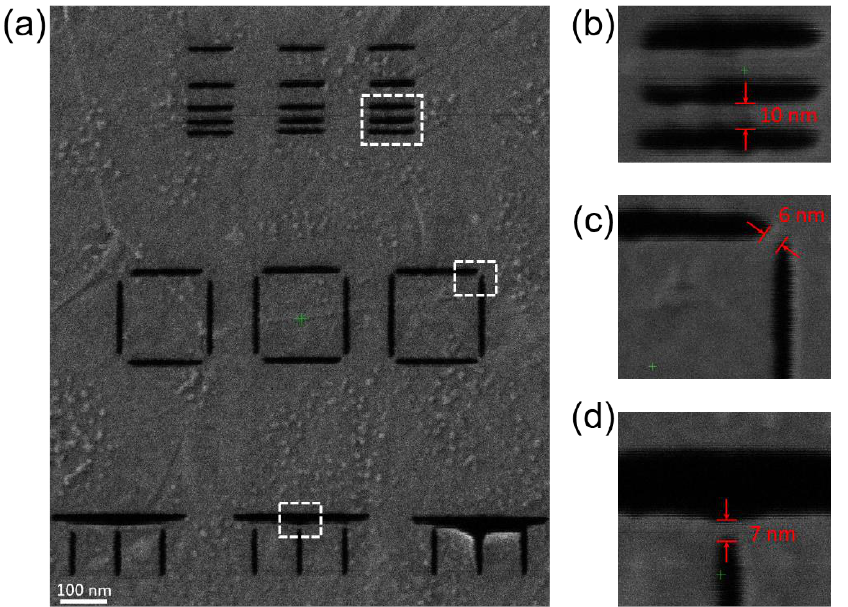
Figure 5. A series of patterns were made to explore of the highest milling resolution ( a ) and the patterning resolution with parallel ( b ), corner ( c ) and vertical ( d ) cuts. The width of the graphene nanobridges in these ions milled features can reach 10 nm in parallel cuts and approximately 6~7 nm in corner and vertical cuts.